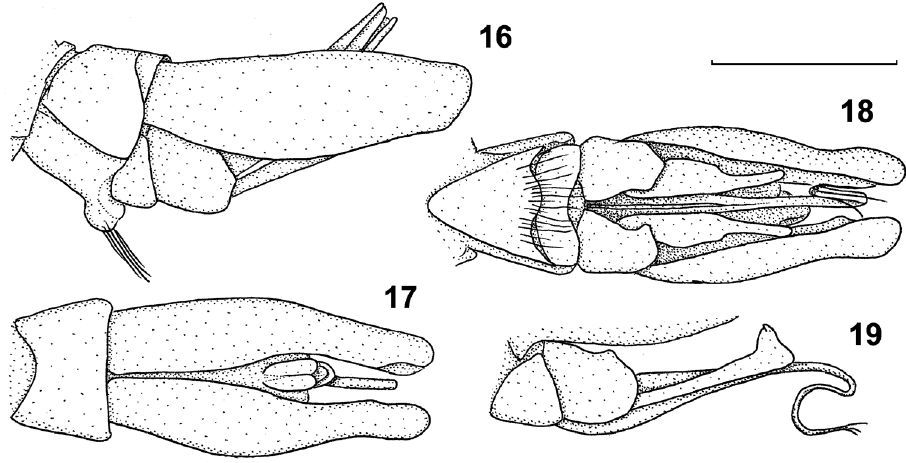
Figures 16–19. Gibbasilus crinitus sp. n. ♂ terminalia, lateral ( 16 ), dorsal ( 17 ), ventral ( 18 ), detail of gonostylus and aedeagus ( 19